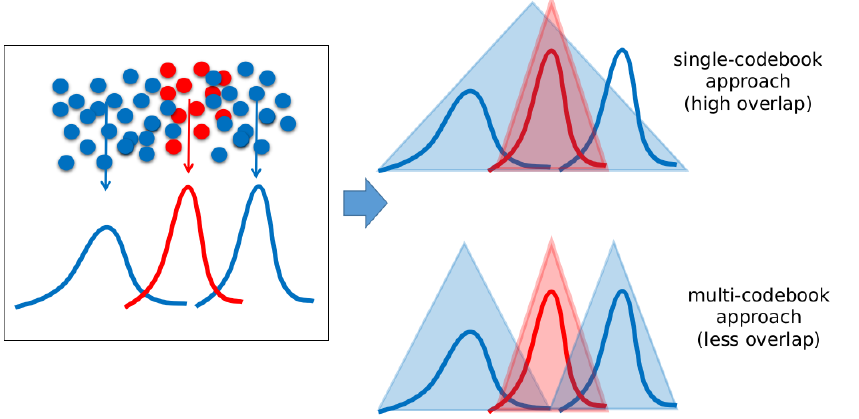
Figure 4. Idea of Multicodebook